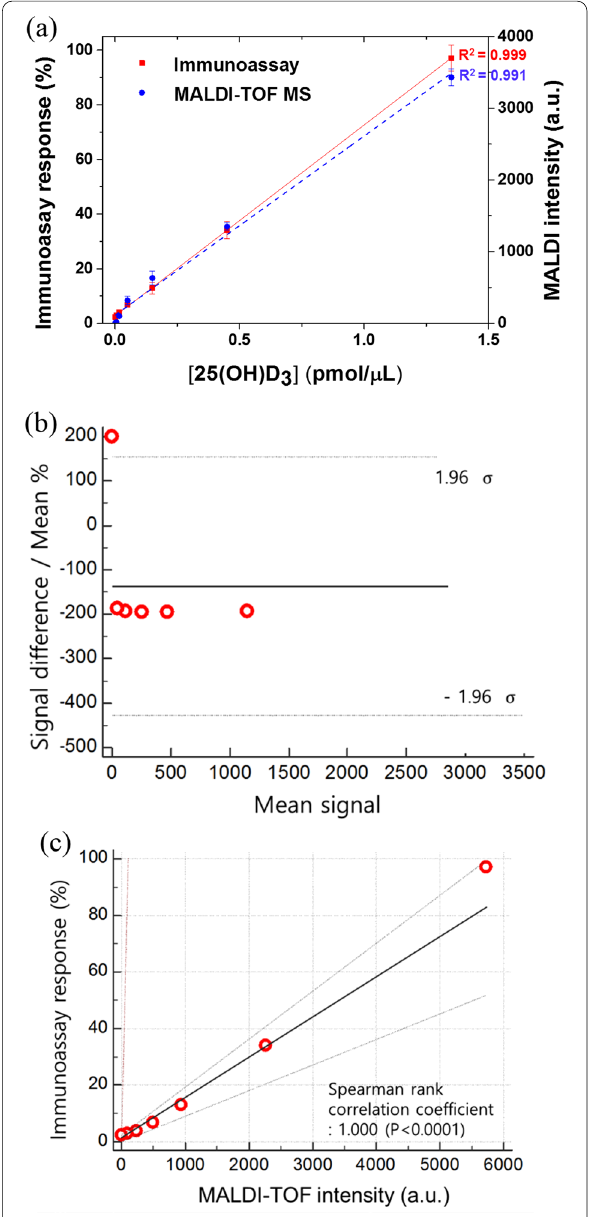
Fig. 6 Statistical analysis between enzyme immunoassay and MALDI‑TOF mass spectrometry. a Comparison of 25(OH)D 3 in serum by enzyme immunoassay and MALDI‑TOF mass spectrometry. b Bland–Altman test. c Passing–Bablok regression